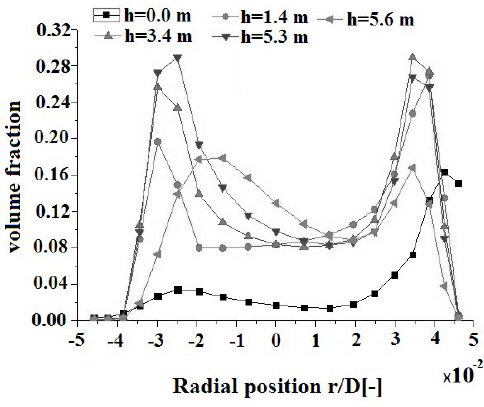
Fig. 7. Radial profiles of solid volume fraction at different heights of